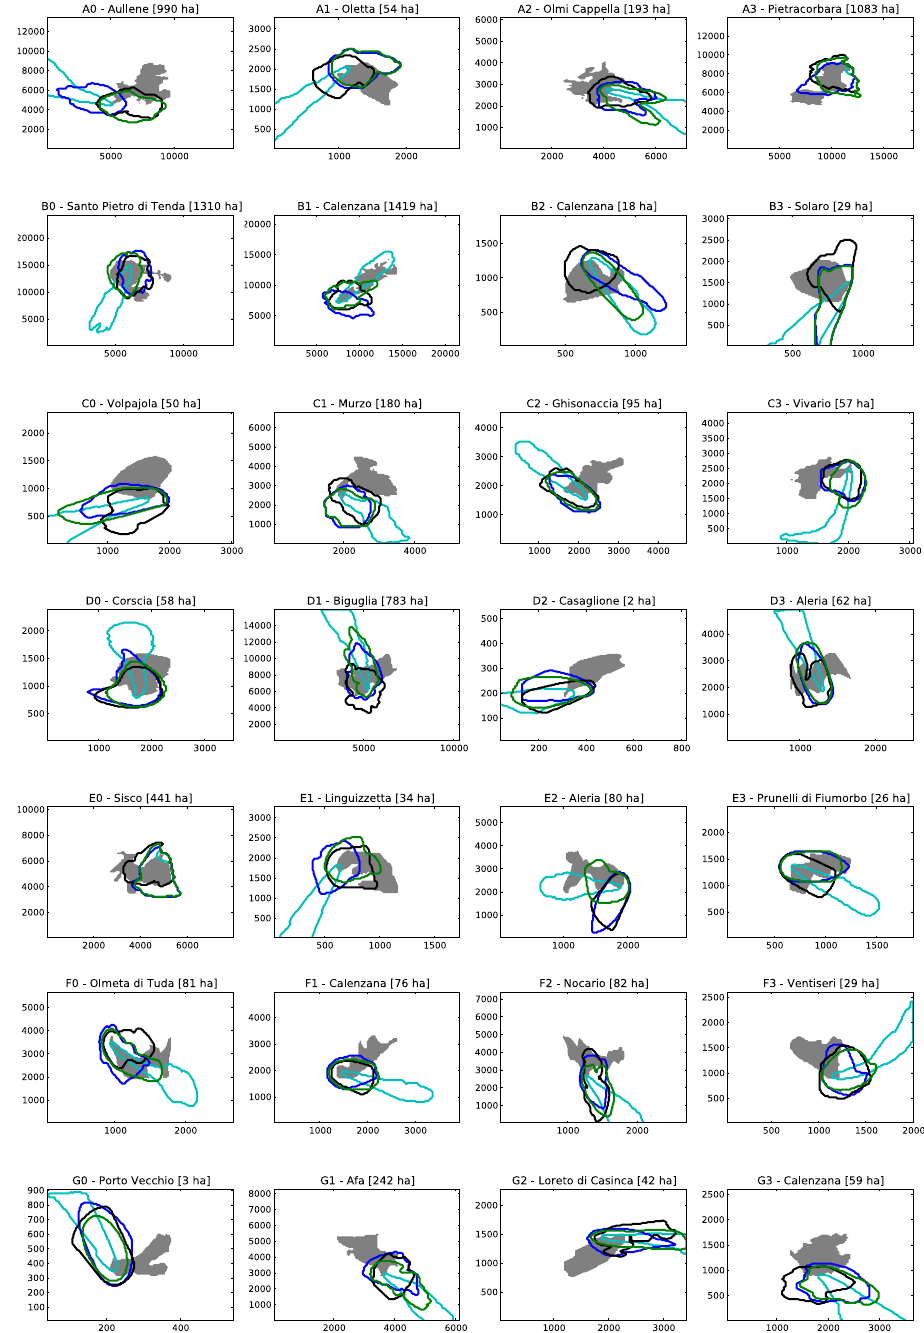
Figure A1. Simulation for all fires (1/3). The non-stationary Balbi model is in blue; the stationary Balbi model is in green; the Rothermel model is in black; the 3-percent model is in cyan. The gray area is the observed final burned area. The coordinates are meters.